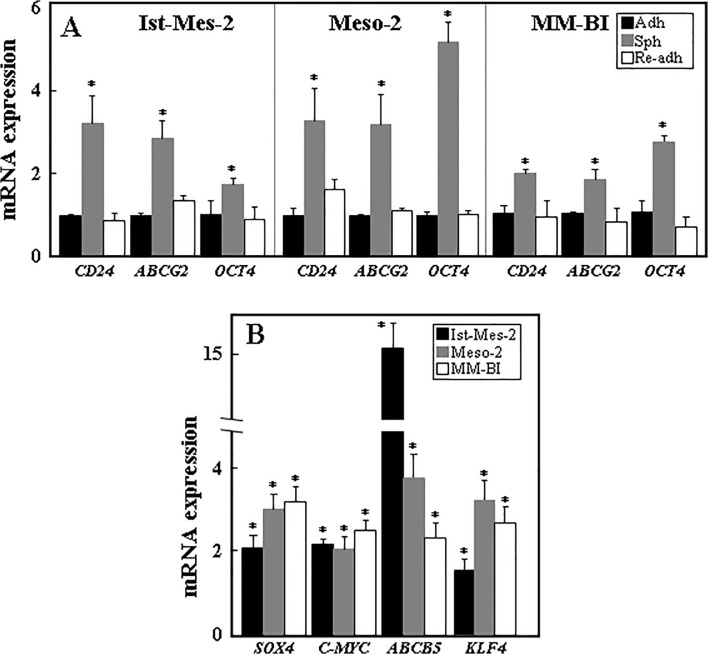
Sphere cells derived from MM cell lines show increased levels of ‘stemness’ markers.(A) Ist-Mes-2, Meso-2 and MM-BI cells were allowed to form spheres, after which these were placed in the complete medium to cause differentiation and re-adhesion of the cells. Relative levels CD24, ABCG2 and OCT4 mRNAs were assessed in the original adherent cells (set as 1), the spheres and the re-adherent cells. (B) Ist-Mes-2, Meso-2 and MM-BI cells spheres were tested for the level of SOX4, C-MYC, ABCB5 and KLF4 mRNA and their level expressed relative to that of adherent cells. The data are mean values ± S.D. derived from three independent experiments, the symbol ‘*’ stands significantly different data with p<0.05, ‘**’ for those with p<0.005.